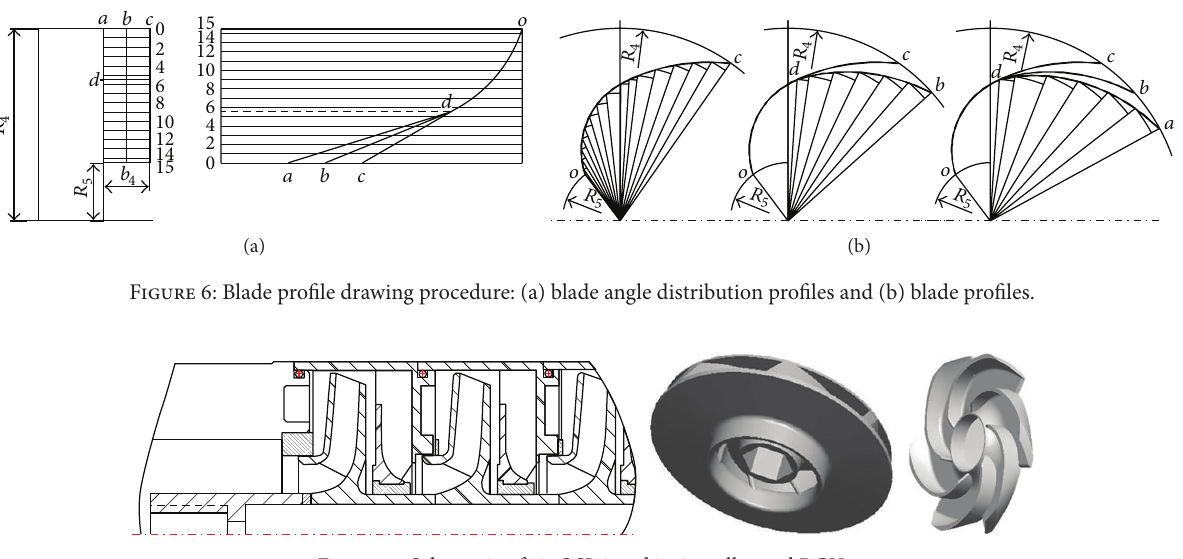
Figure 7: Schematic of 125QSJ10 and its impeller and RGV.